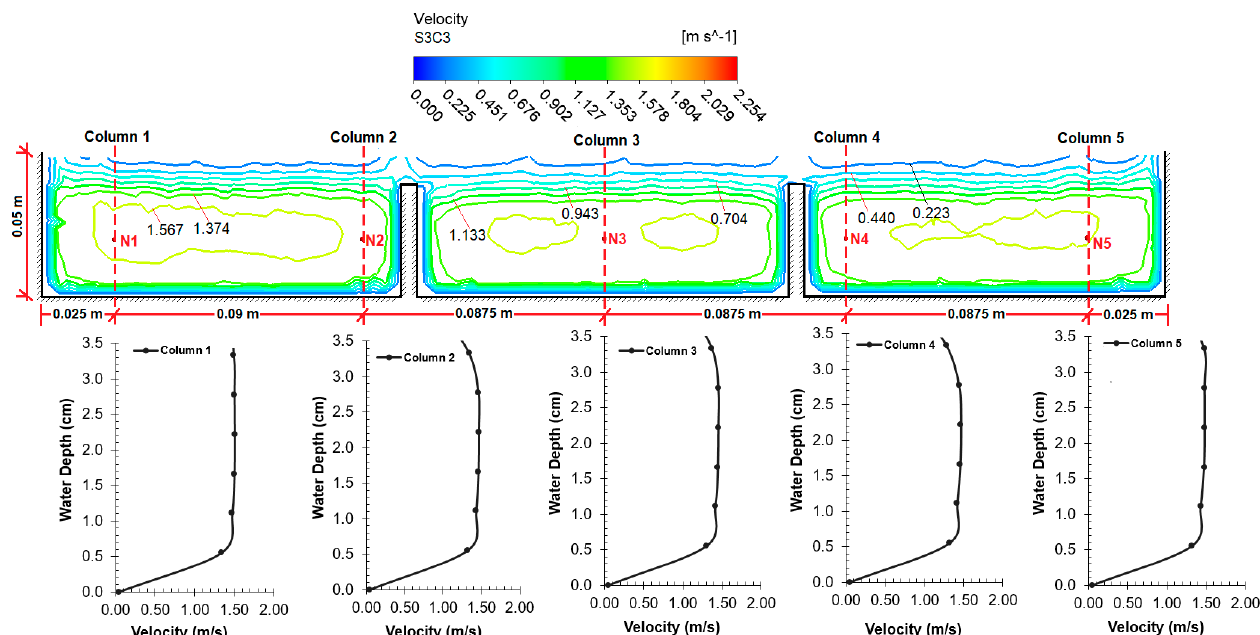
Figure 17. CFD velocity contours and depth-velocity distributions for Cross-section 3.